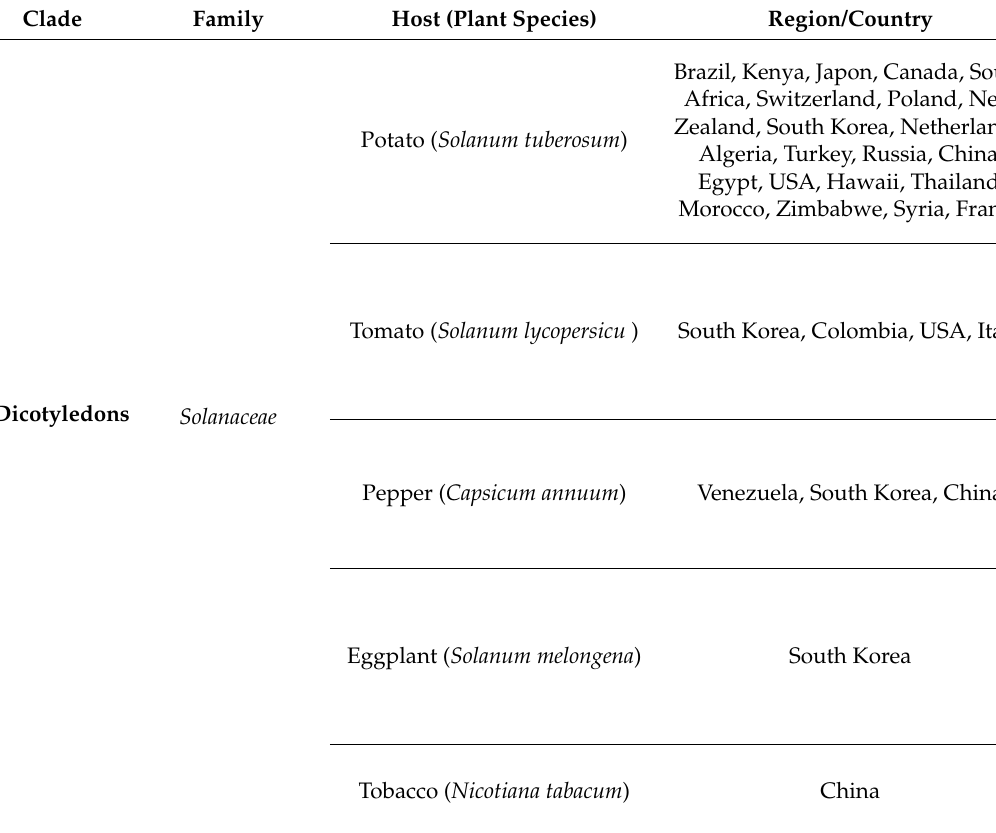
Table 1. Hosts range, disease symptoms and geographical distribution of